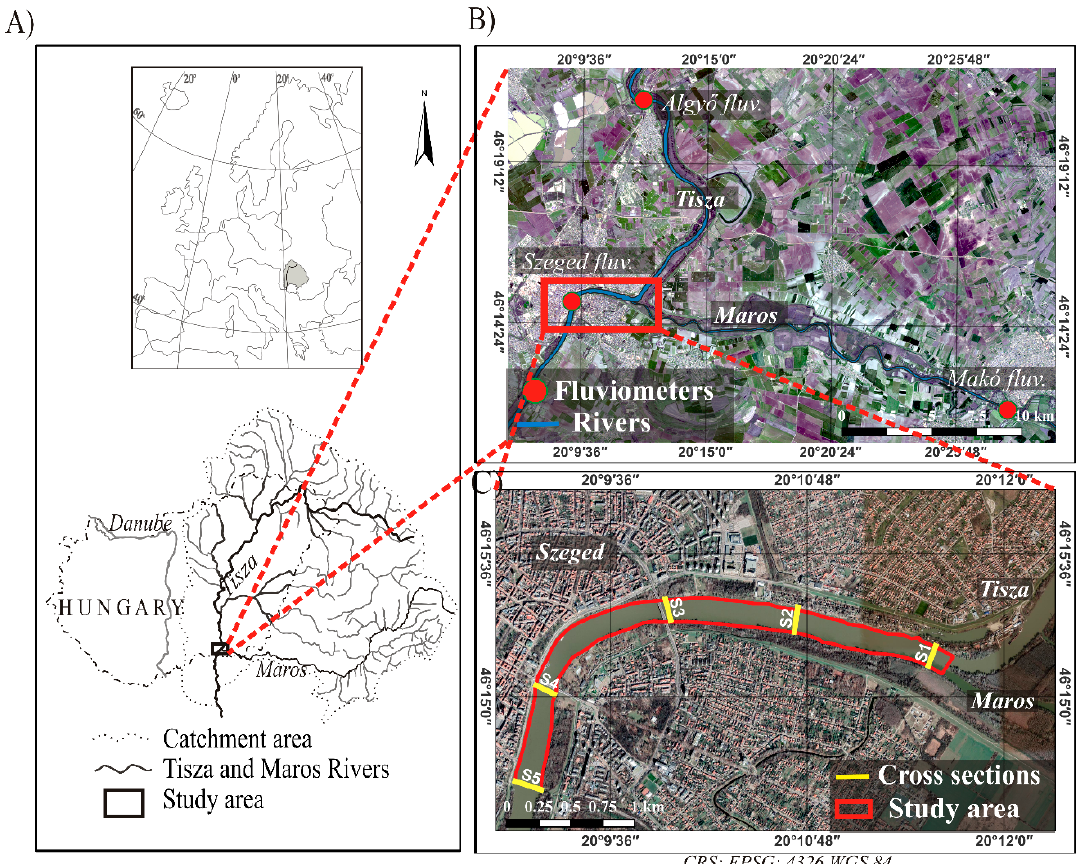
Figure 1. The confluence of the Tisza and Maros Rivers in Hungary was studied in detail. ( A ) Catchment area of the Tisza and Maros Rivers. ( B ) Locations of the three fluviometers along the Tisza (Algy ő , Szeged) and Maros Rivers (Makó). ( C ) In the confluence area, the mixing was studied in detail at five cross sections (S1-5). (Source of the background images: B: Sentinel ‐ 2; C: Google satellite).